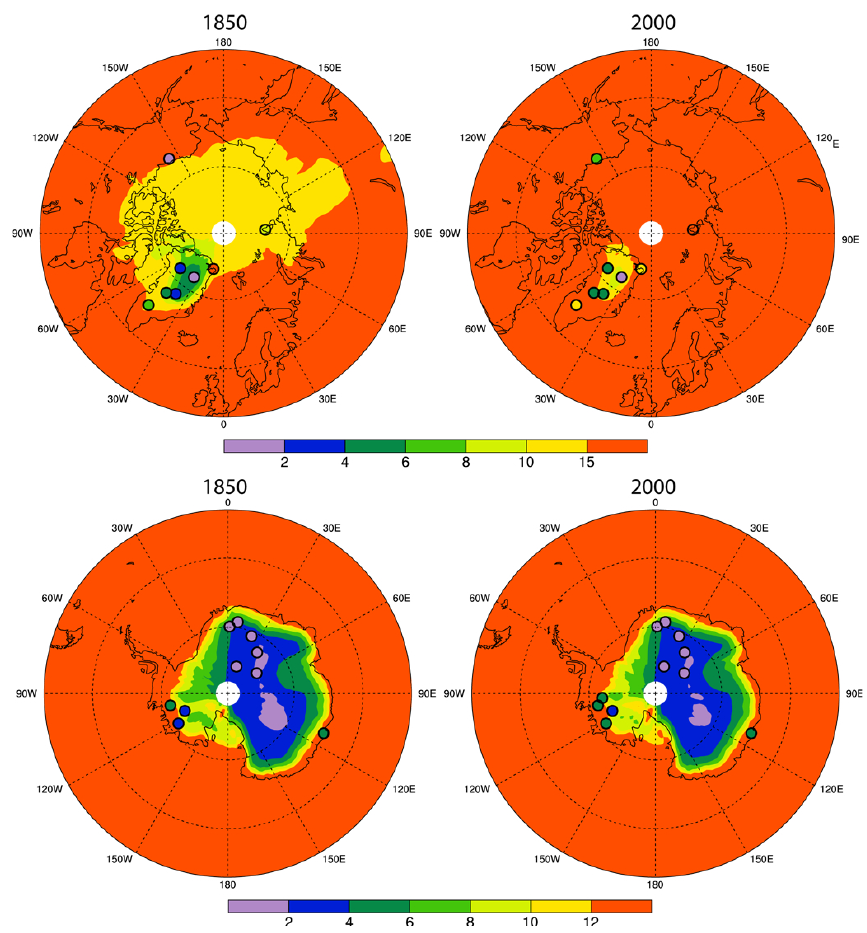
Fig. 4c. Sulfate deposition from ice cores (mg(S)m − 2 yr − 1 , filled circles, see Table S5) and MMM for 1850 (left column) and 2000 (right column). Top panel is for the Arctic region; bottom panel is for the Antarctic region. Contours are the MMM results; filled circles are the observations. Note different color scales between top and bottom